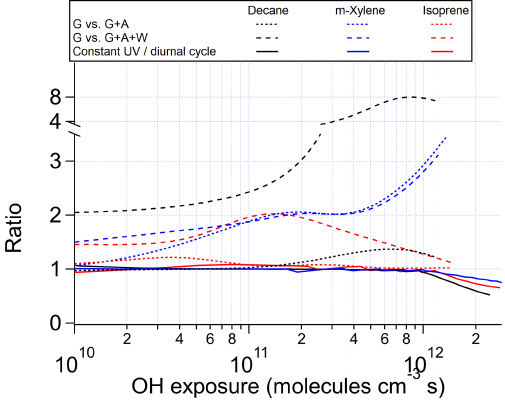
Figure 2. Ratios of OHR of the products present in the gas phase between the chamber cases without gas–particle–wall partitioning and (i) with gas–particle (G vs. G + A) or (ii) gas–particle–wall par- titioning (G vs. G + A + W) at initial OHR of 10s − 1 , as well as be- tween the ambient cases with constant and diurnal sunlight for the photooxidations of decane, m -xylene, and isoprene as a function of OH